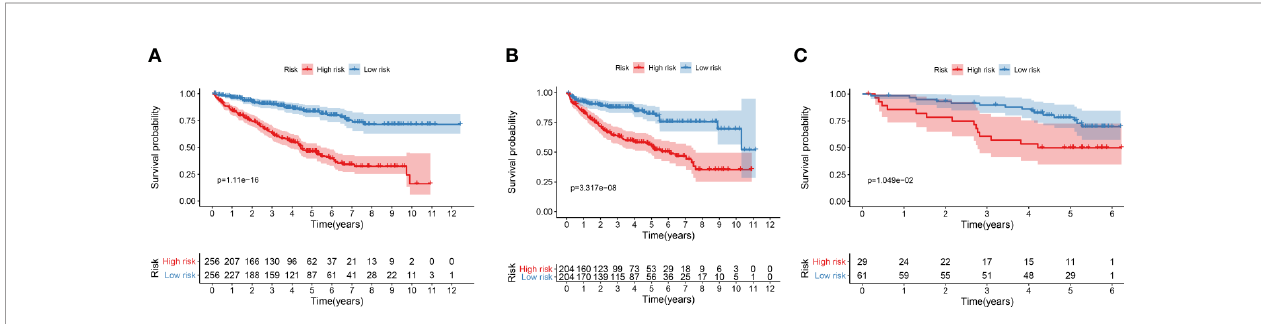
FIGURE 2 | Kaplan-Meier curve analysis for the OS (A) and DFS (B) of the EMT-related signature in the TCGA dataset, and OS in the ICGC dataset (C) .